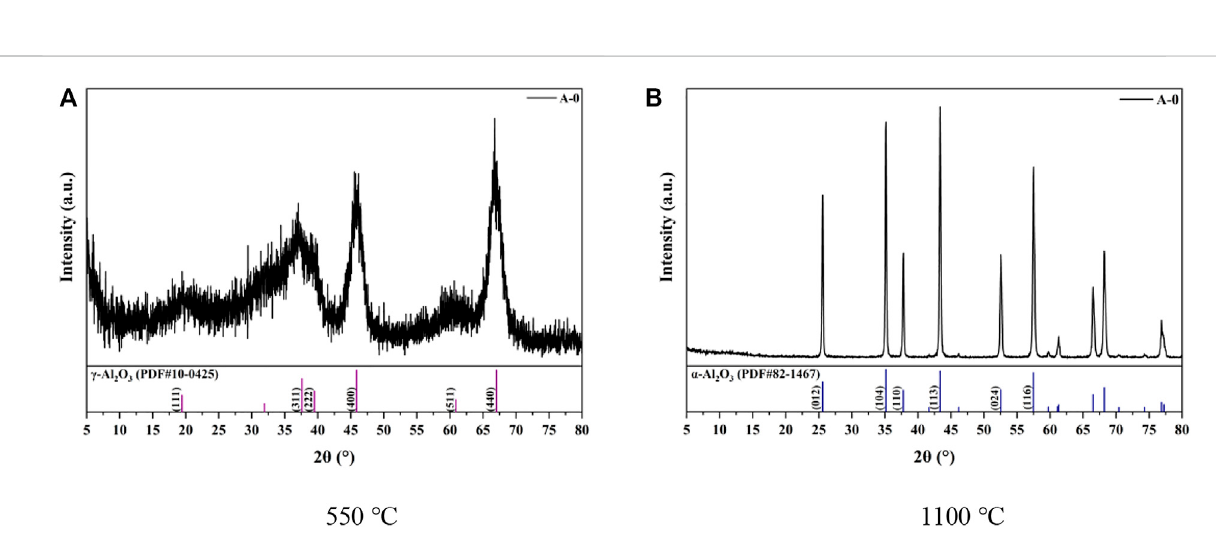
FIGURE 2 XRD pattern of Al 2 O 3 calcined at 550 ° C and aged at 1,100 °